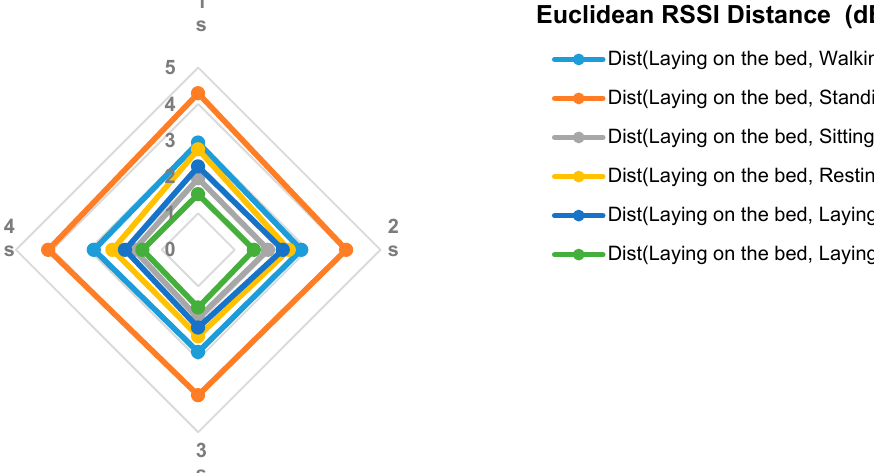
Figure 8. System performance for laying on bed position over a stipulated